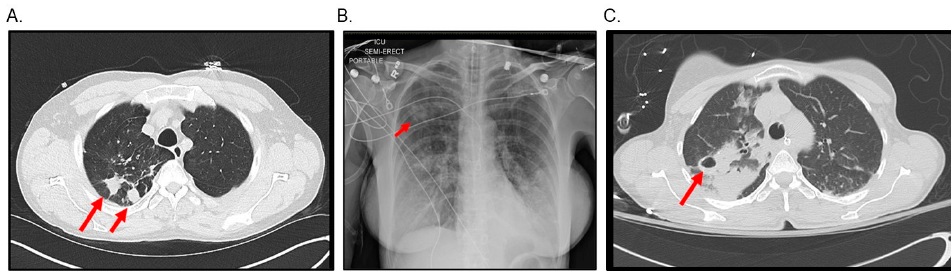
Figure 1. Radiologic abnormalities of patients with pulmonary MAC. ( A ) Chest CT of a 60-year-old female patient diagnosed of nodular pulmonary MAC. She completed treatment and remained culture negative for several months. ( B , C ), a chest X-ray and chest CT of a 60-year-old female patient recently diagnosed with fibrocavitary pulmonary MAC. Arrows show specific lesions.